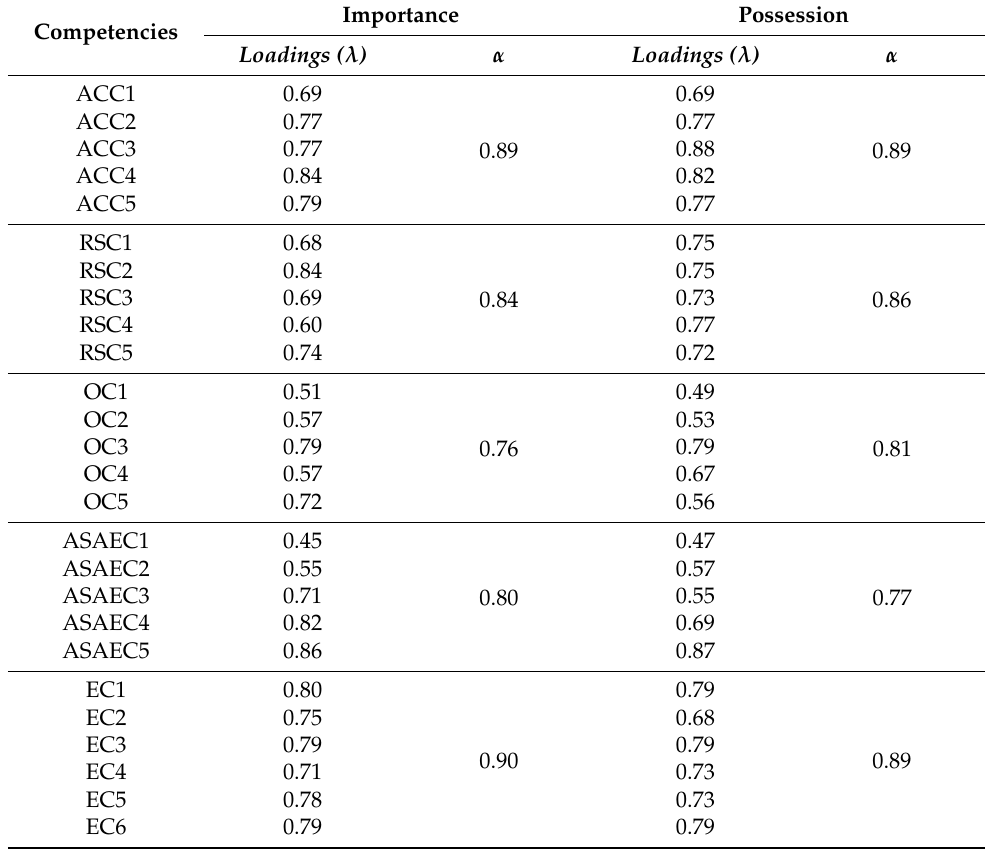
Table 3. The validation factor analysis of